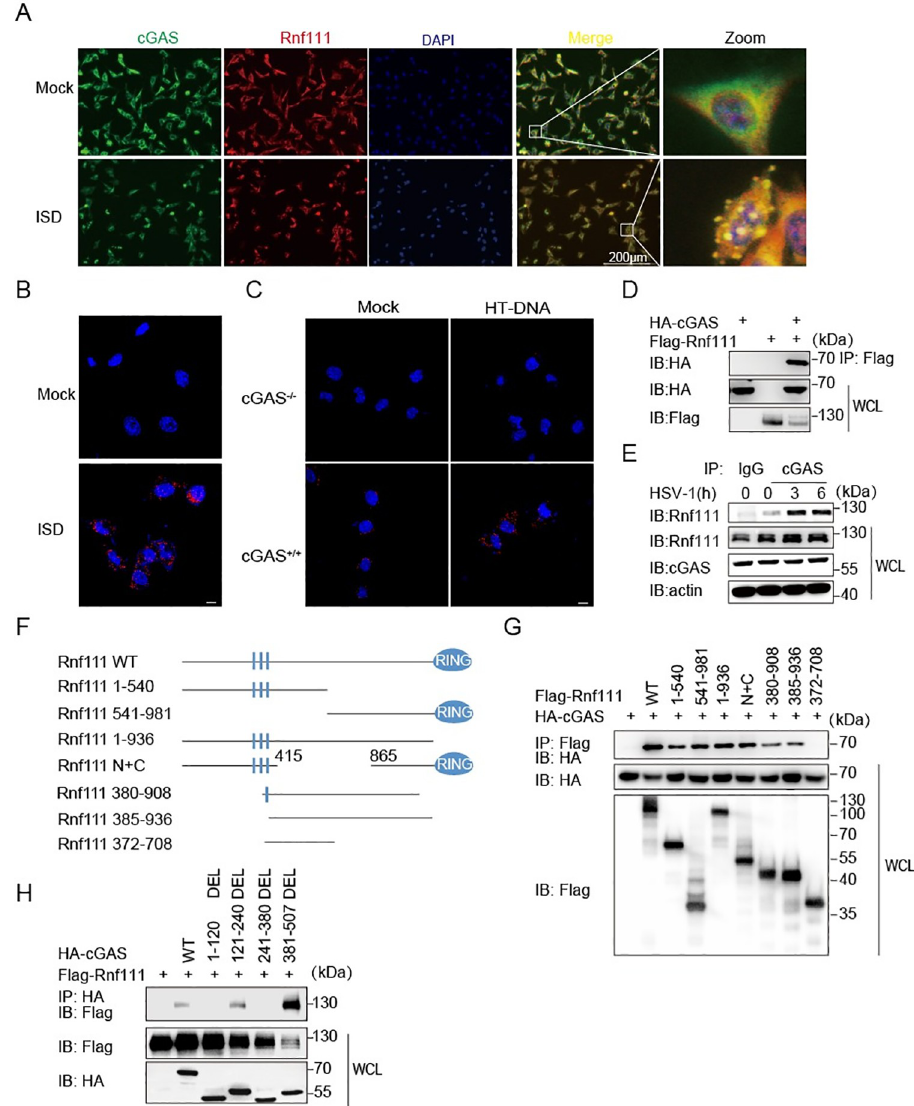
Fig 4. Rnf111 interacts with cGAS. (A) MEFs were stimulated with ISD for 3h, stained with indicated antibodies and imaged by confocal microscopy. Scale bars represent 200 μ m. (B) MEFs were stimulated with ISD for 3h, then PLA analysis was applied to detect the interaction between cGAS and Rnf111. Scale bars represent 10 μ m. (C) WT or cGAS-/- L929 were stimulated with HT-DNA for 3h, then PLA analysis was applied to detect the interaction between cGAS and Rnf111. Scale bars represent 10 μ m. (D) HEK293T cells were transfected with indicated plasmids, 24h after transfection, cell lysis was immunoprecipitated with an anti-Flag antibody and then immunoblotted with indicated antibodies. (E) MEFs were infected with HSV-1 (MOI = 0.5) for the indicated time, cell lysis was immunoprecipitated with an anti-cGAS or IgG antibodies and then immunoblotted with indicated antibodies. (F) Diagrams of Rnf111 truncations used in this paper. (G) HEK293T cells were transfected with indicated plasmids for 24h, then cell lysis was immunoprecipitated with anti-Flag antibody and then immunoblotted with indicated antibodies. (H) HEK293T cells were co-transfected with plasmids of different truncations of cGAS and Rnf111, 24h after transfection, lysates of HEK293T were immunoprecipitated with anti-HA antibody and then immunoblotted with indicated antibodies.